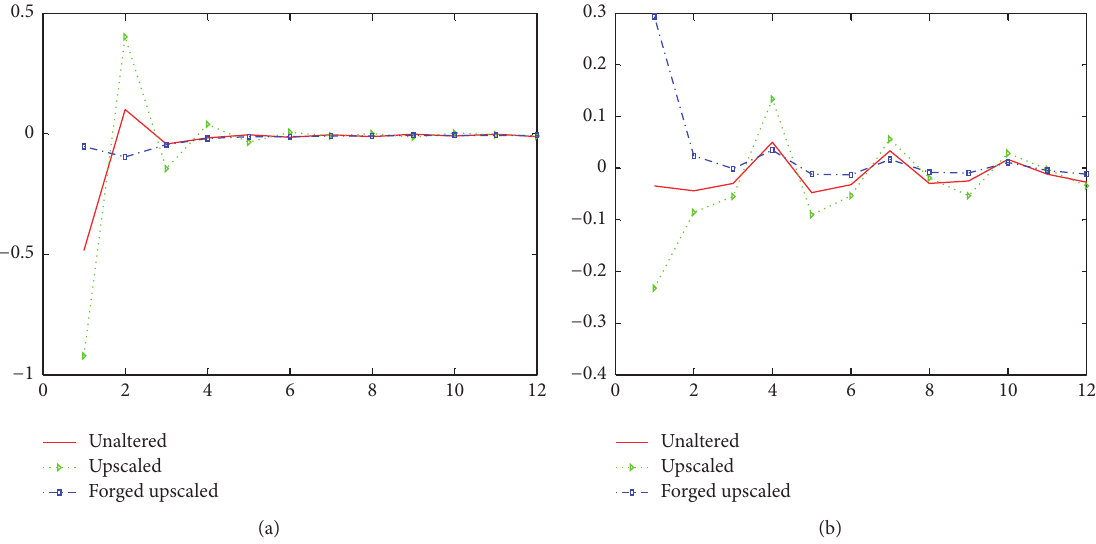
Figure 5: The distribution of FAR 0 1 (a) and FAR 1 1 (b) for 1500 uncompressed unaltered images and their upscaled ( 𝑠 = 3/2 , bicubic) and forged upscaled ( attack 1, 𝑠 = 3/2 , 𝜎 = 0.4 , bicubic) versions. 𝑋 -coordinate: the index of AR coefficient; 𝑌 -coordinate: averaged value of AR coefficient.